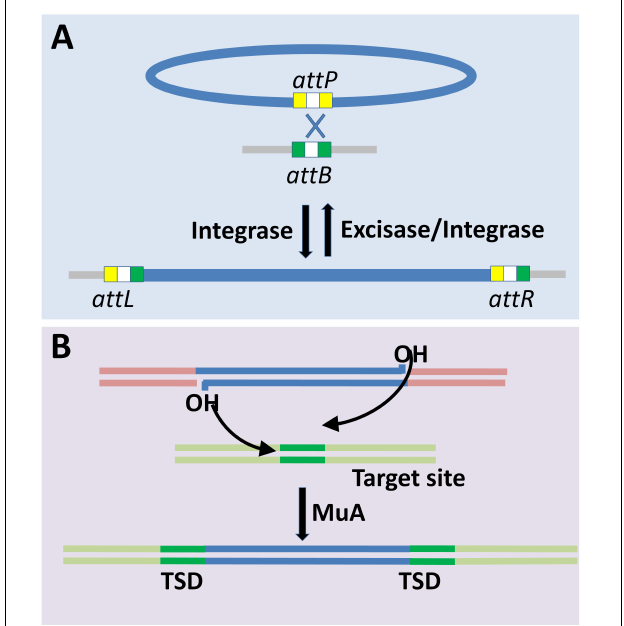
FIGURE 2 | Mechanisms of bacteriophage genome integration into bacterial chromosome. (A) Site-specific recombination mediated-lysogenization is well characterized for lambdoid phages. Site-specific recombination is catalyzed by the integrase through phage and bacterial attachment sites ( attP and attB, respectively) resulting in recombinant attL and attR sites (Landy and Ross, 1977; Menouni et al., 2015). Prophage induction is mediated by excisase and integrase complex. (B) Transposition based integration of Mu phage into the target site in the host genome requires MuA transposase. The integration results in target site duplication (TSD) (Allet, 1979; Harshey,